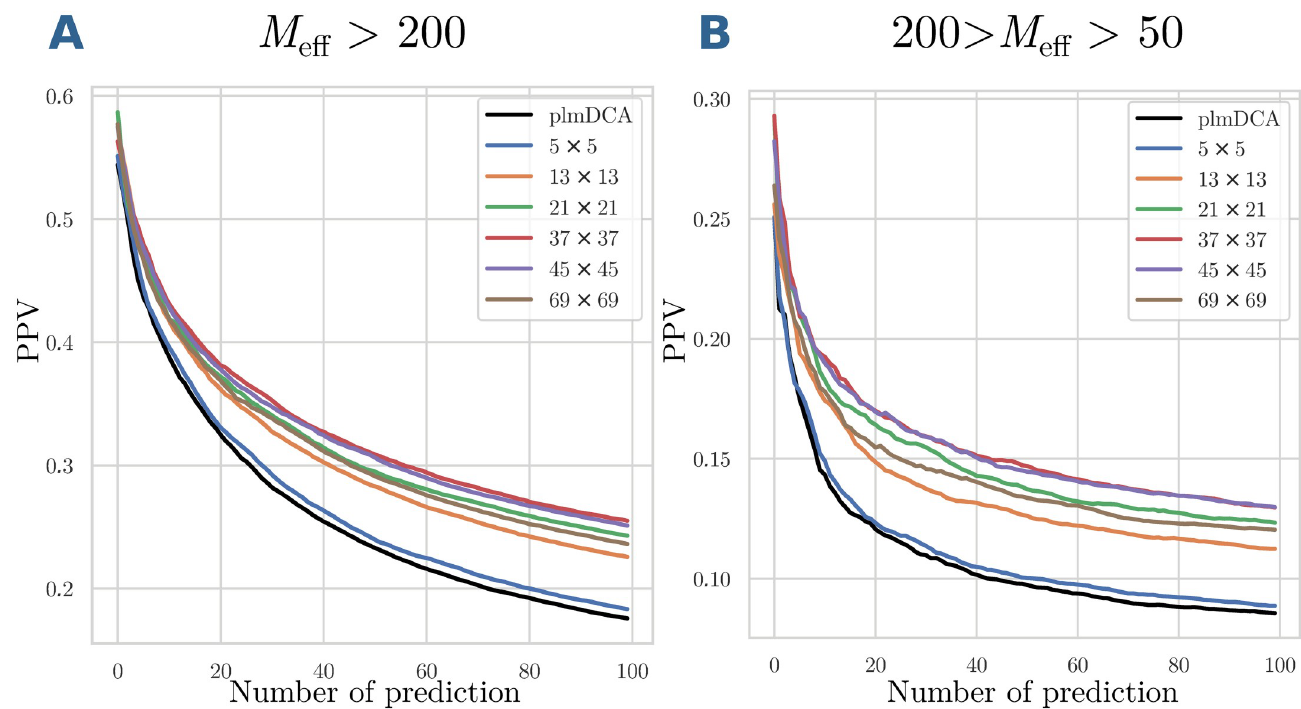
Fig 5. Positive predictive values of FilterDCA for inter-domain contact prediction. PPV are shown as a function of the number of predictions for large (panel A) and medium (panel B) MSA sizes, averaged over the different domain-domain interactions in the test set. Different filter sizes are compared to standard